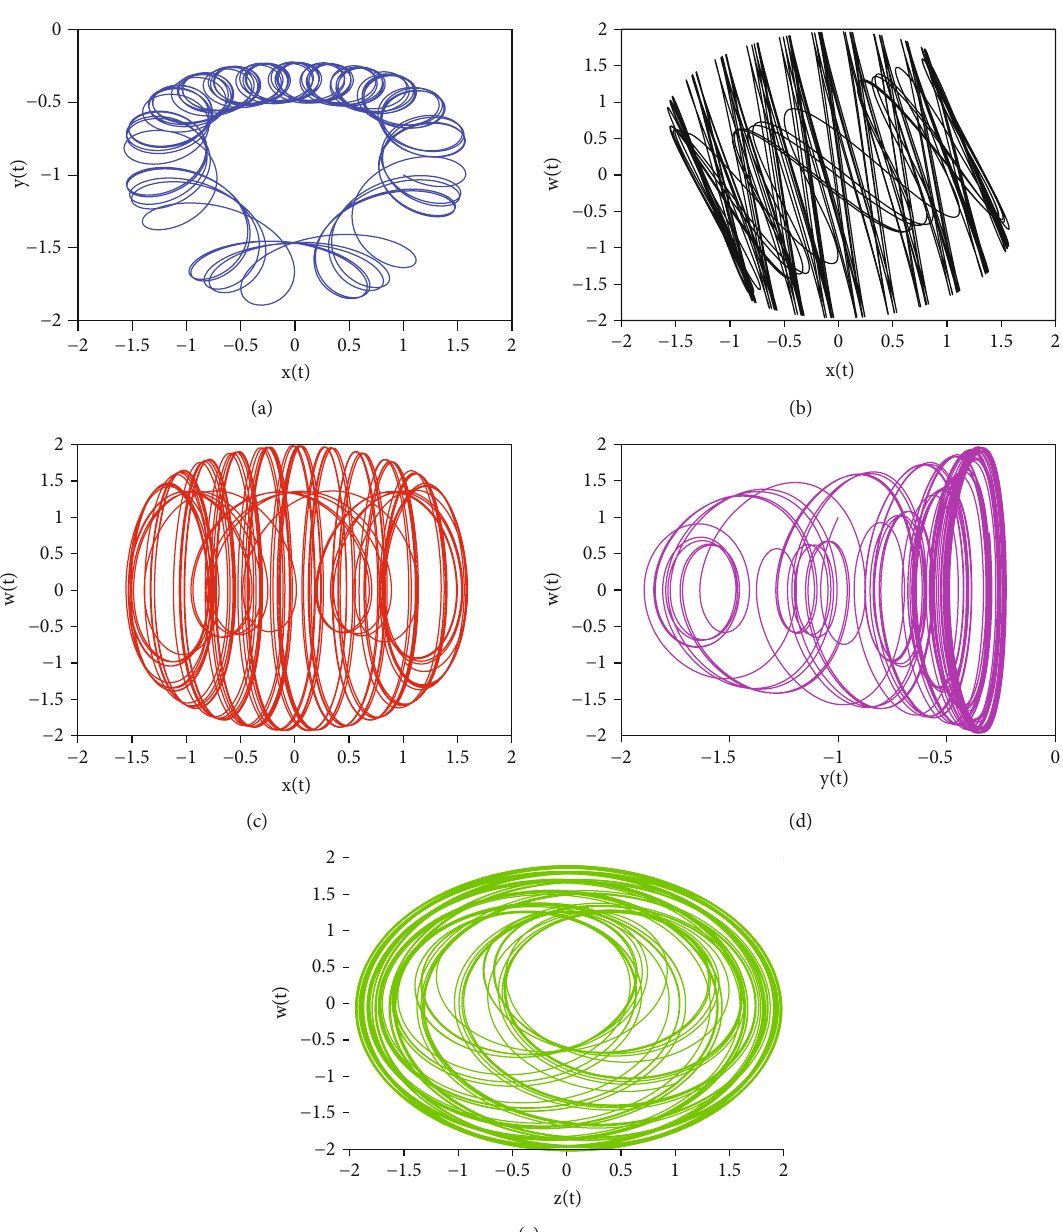
Figure 13: The behavior of di ff erent state variables of system 2 with fractional order ϖ = 1